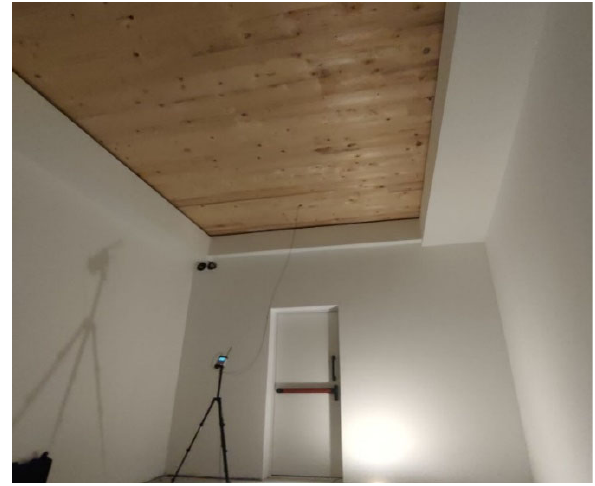
Figure 1. Laboratory receiving room and CLT floor.